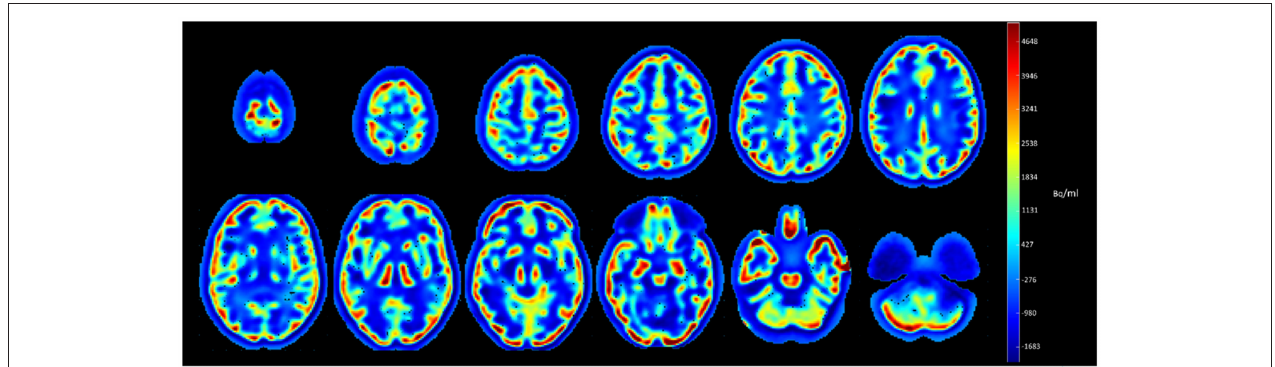
FIGURE 1 | Subtracted axial slices of Hoffman 3-D brain phantom images reconstructed with and without PSF.